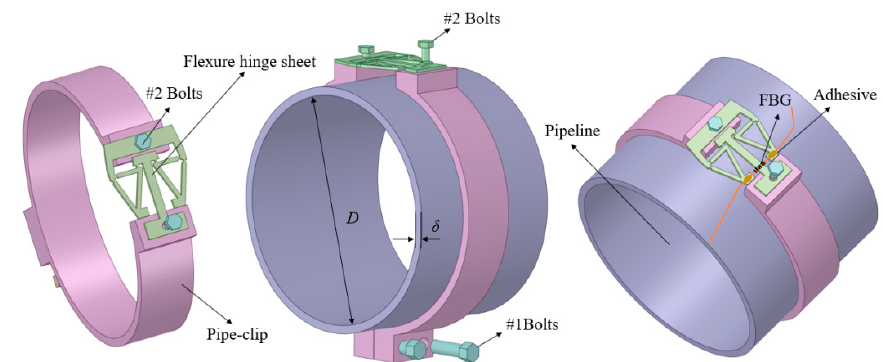
Figure 2. The proposed sensitization structure and assembly diagram.